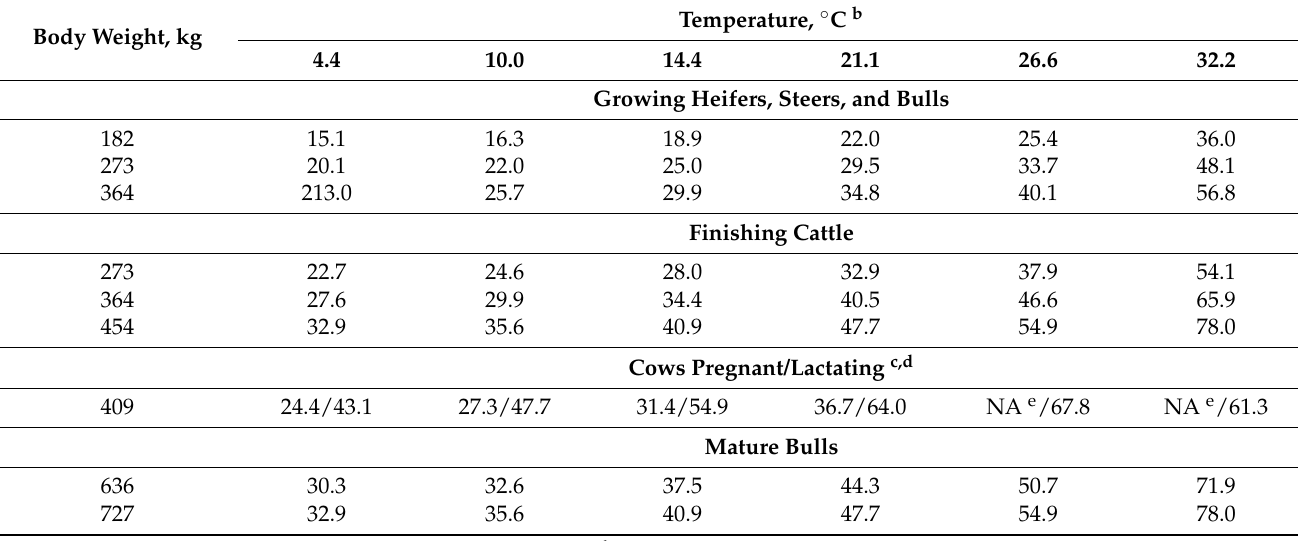
Table 1. Influence of temperature, cattle type, and body weight on estimated daily water intake (L) for beef cattle a,b . Body Weight,